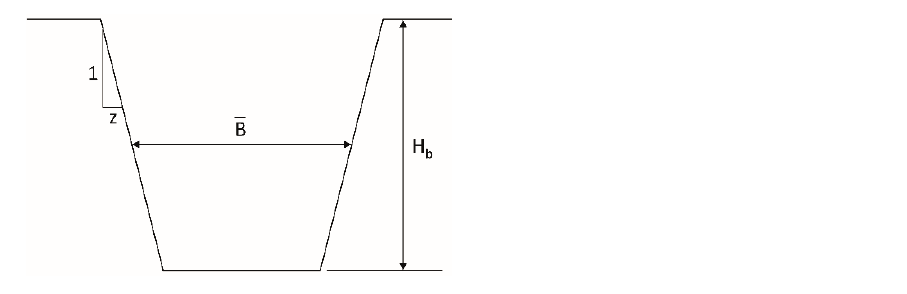
Table 1. Anticipated outburst volumes, corresponding breach depths and dam breach parameters calculated by the equations of Fröhlich [29].